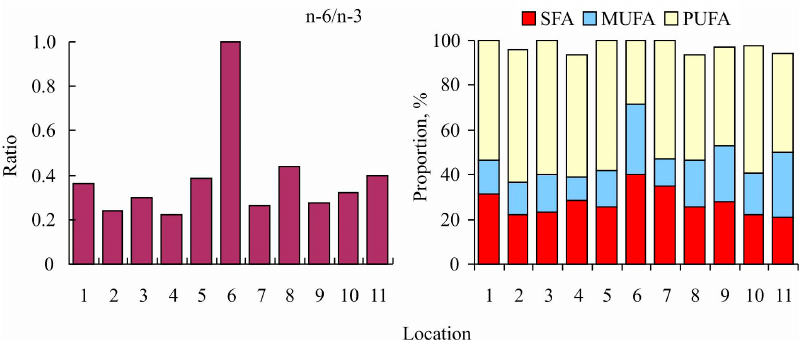
Figure 2. Spatial variations in the n-6/n-3 ratio and fatty acid contents in the flesh of northern pike. For abbreviations, see Figure 1 and Table 2.